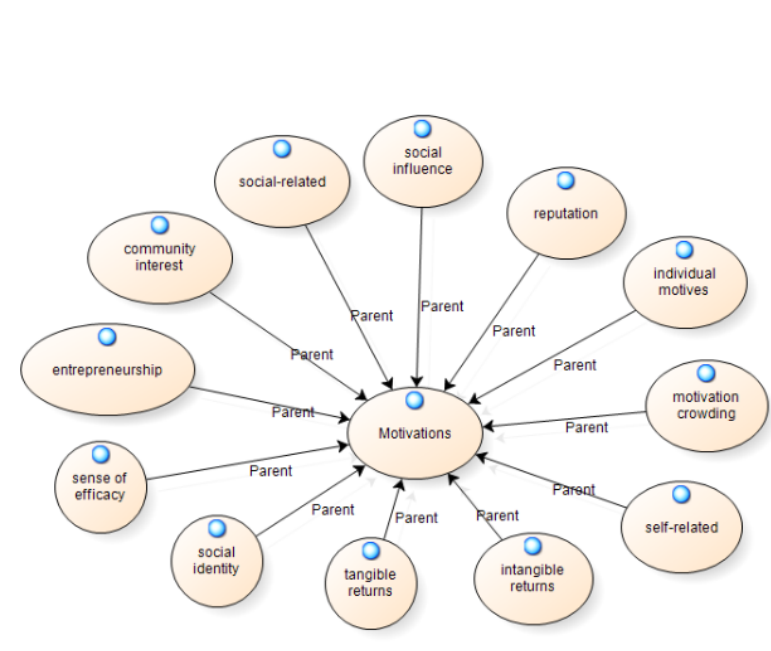
Fig. 4. Overview of Participants’ Motivations for